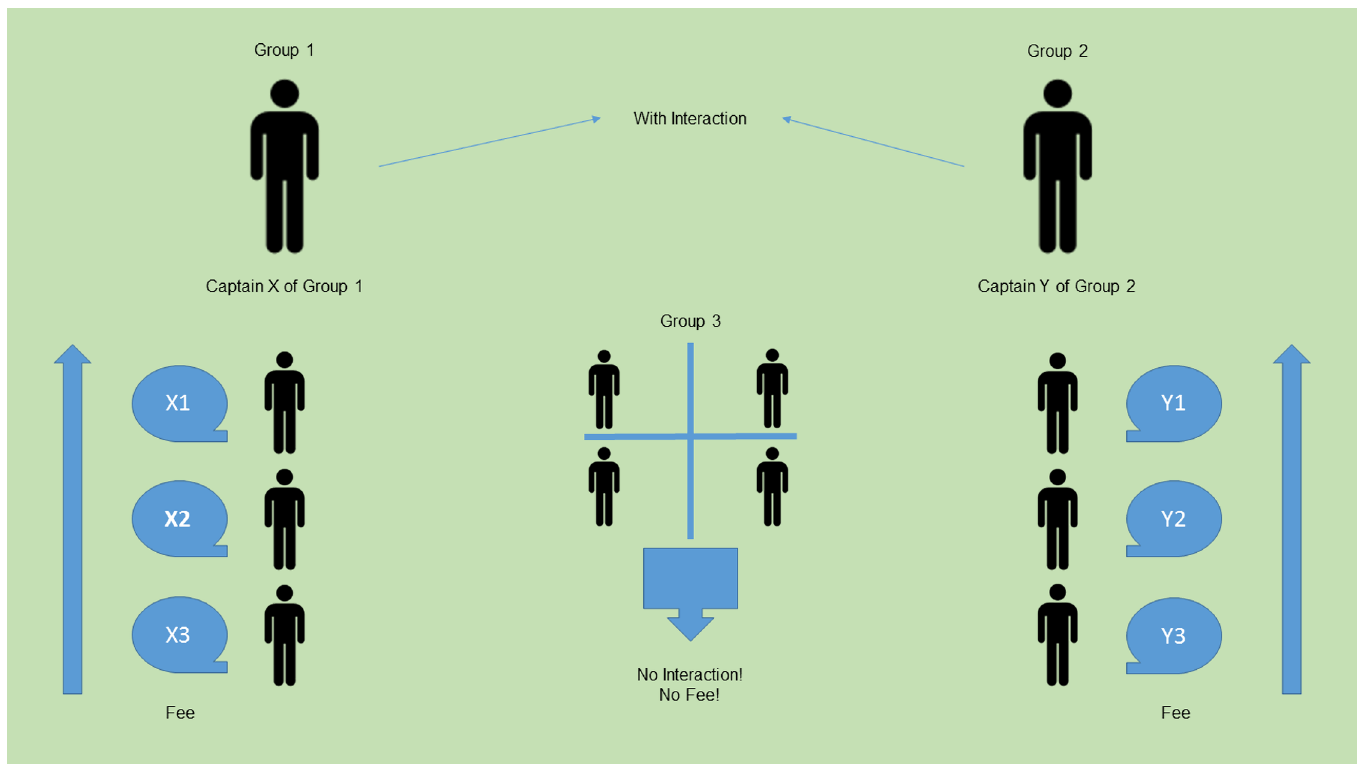
Fig 2. The illustration of the group formation during the Socialization stage. Two captainsare chosen as volunteers from amongthe participants. Other participants must choose the captainwhose team they want to join and how many points they are preparedto pay for that. The four participants, who paid less than the others, continueas individualparticipants in Group 3; they are forbidden to communicate or even look at each other. The participants in the teams with captainsform Group 1 and Group 2.